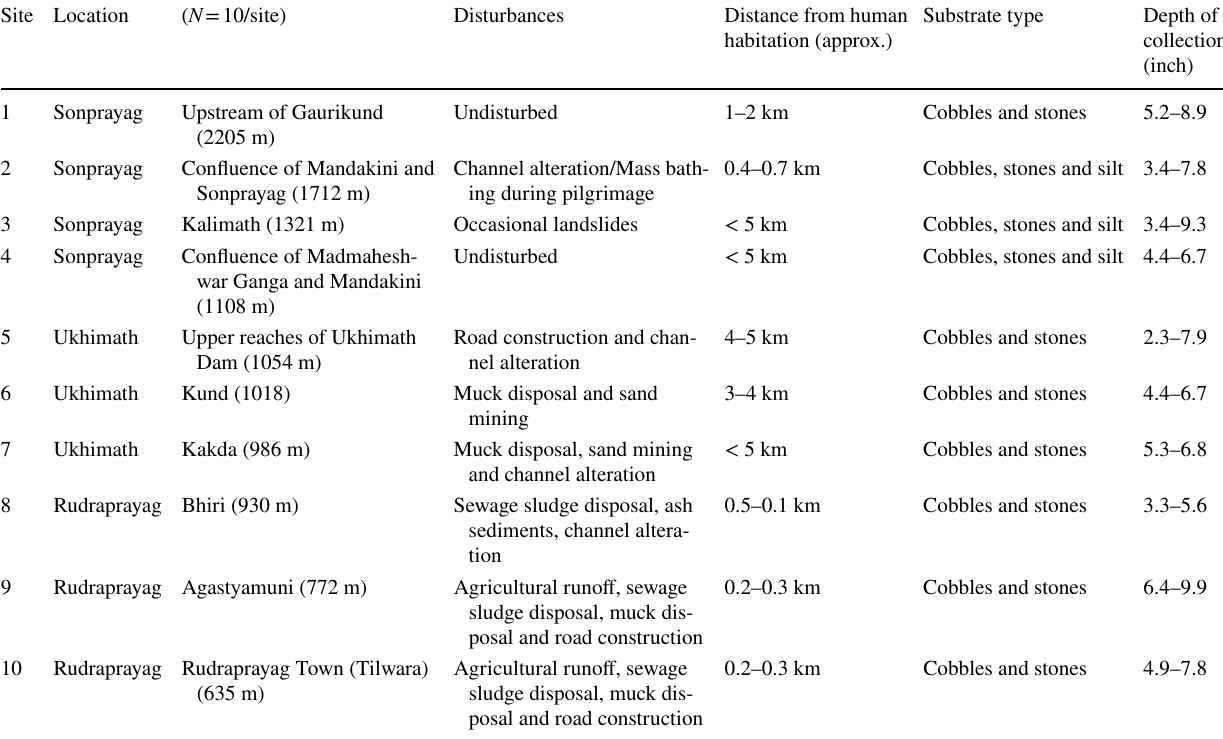
Table 1 Macroinvertebrate sampling location in different areas of Mandakini River Site